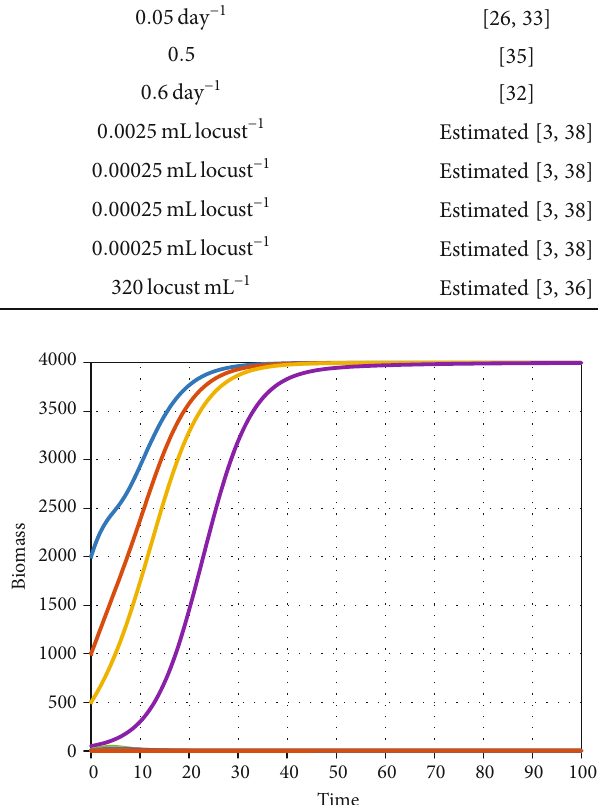
Figure 1: The trajectories of system (2) with the baseline parameters in Table 1 and varying the initial values. The interior equilibrium (3719.43, 12.0255, 1.0014, 130.269) of system (2) is asymptotically